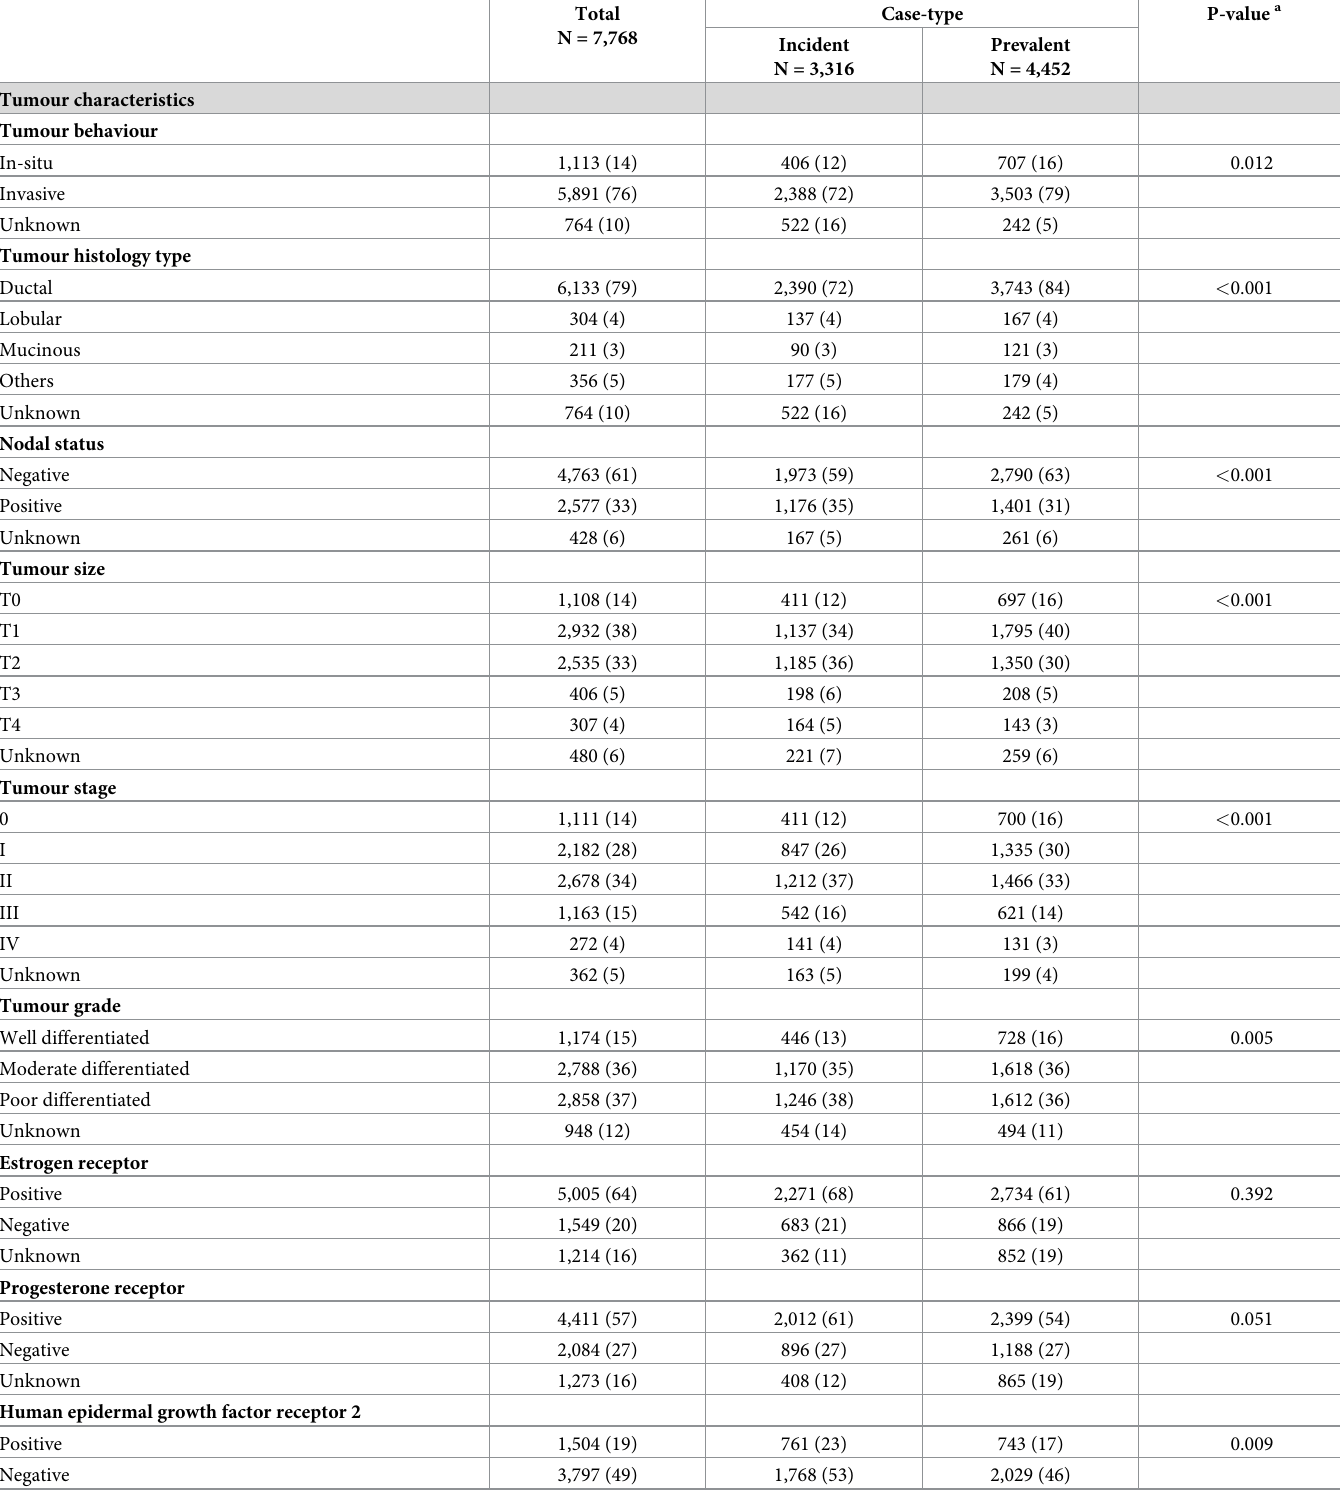
Table 2. Association between clinical characteristics and case status (incident or prevalent breast cancer), using the Chi-square